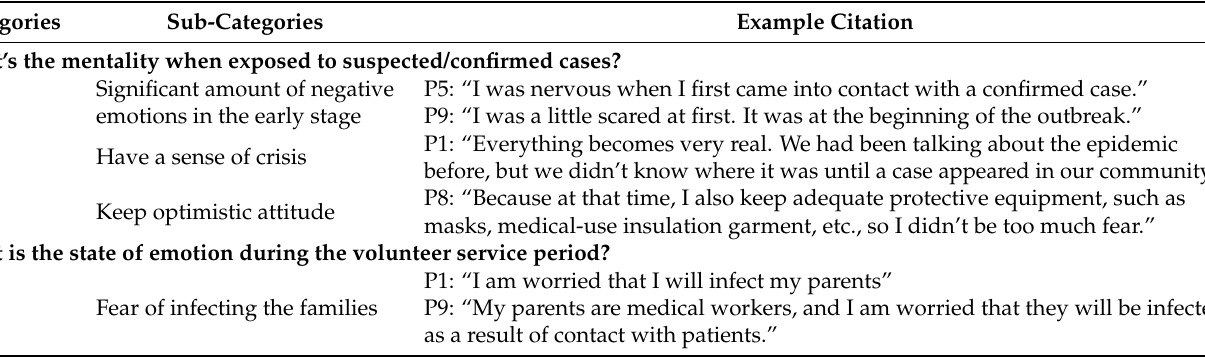
Table 3. Psychological impact by medical student